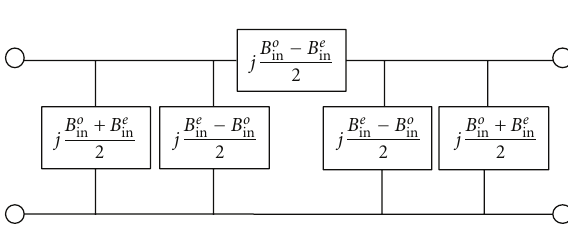
Figure 4: Equivalent